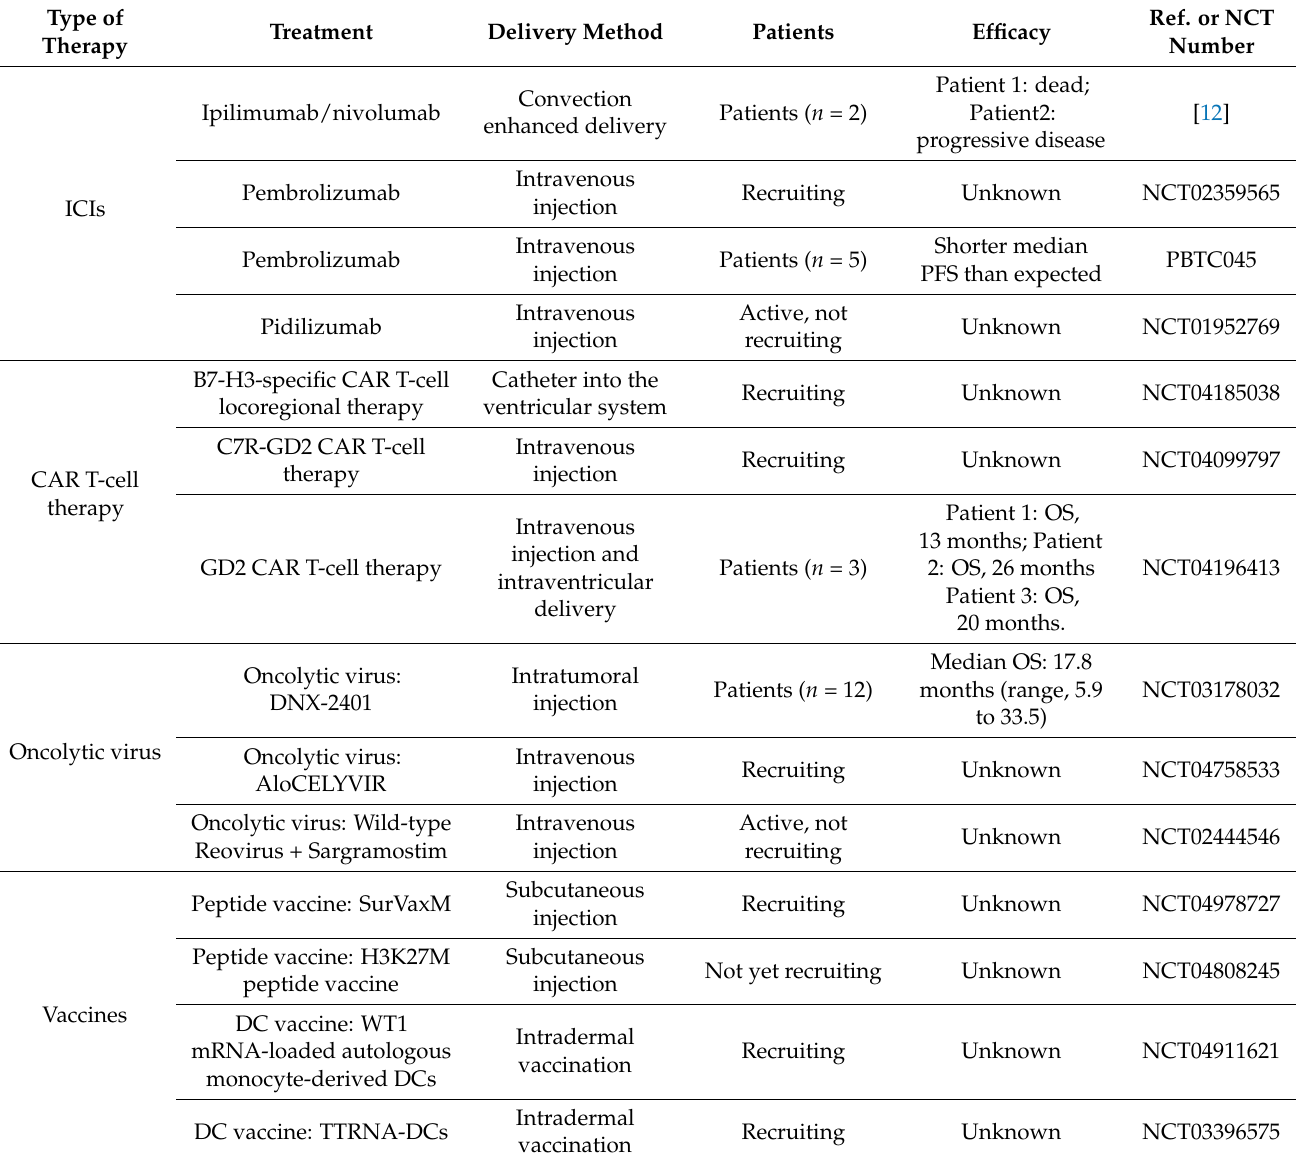
Table 2. Current clinical trials of DIPG